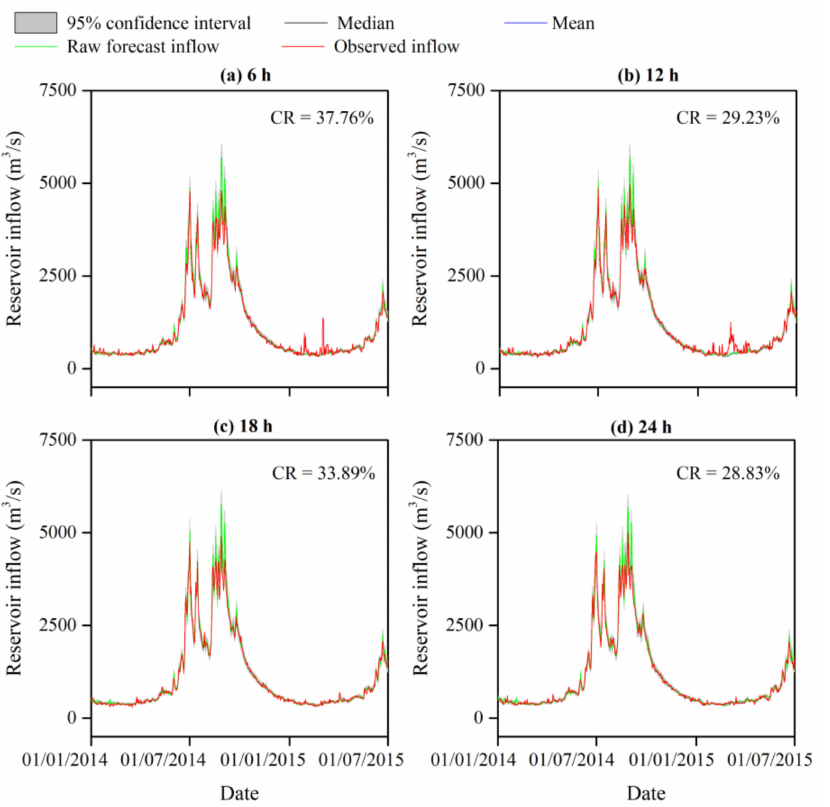
Figure 10. Same as Figure 8 but for the SGD